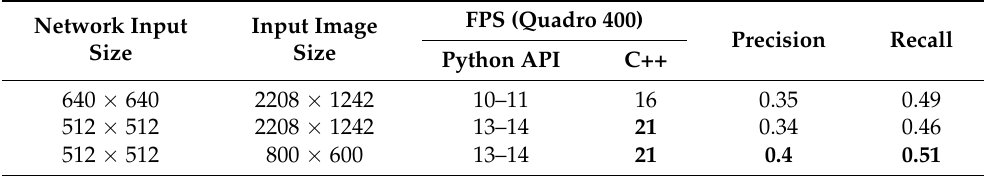
Table 3. Performance comparison for YOLOv4 with smaller